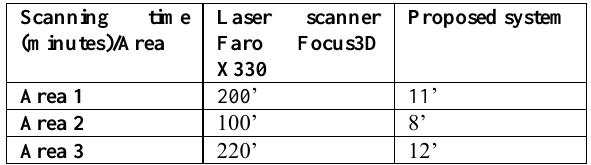
Table 1. Data acquisition time used by the proposed prototipe and the laser scanner Faro Focus3d X330.